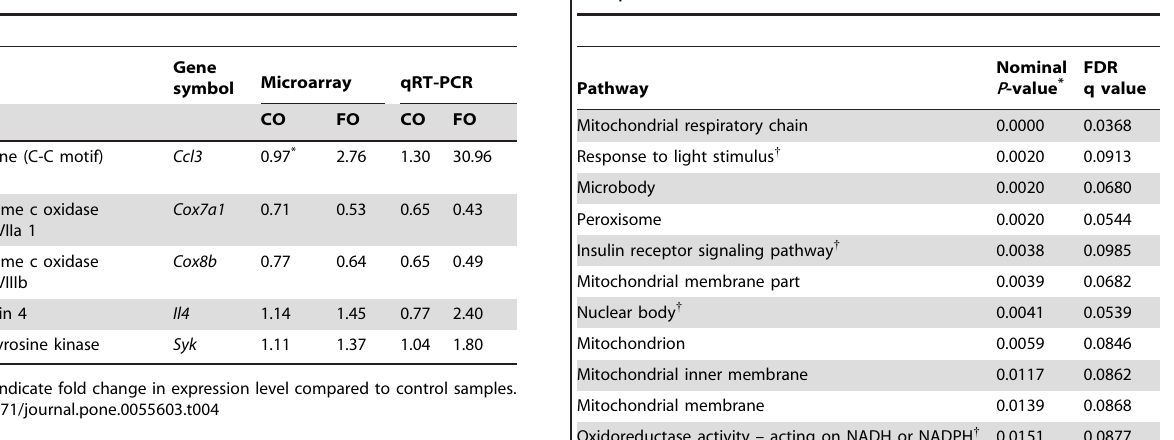
Table 4. Expression levels of selected genes in the CO and FO groups.